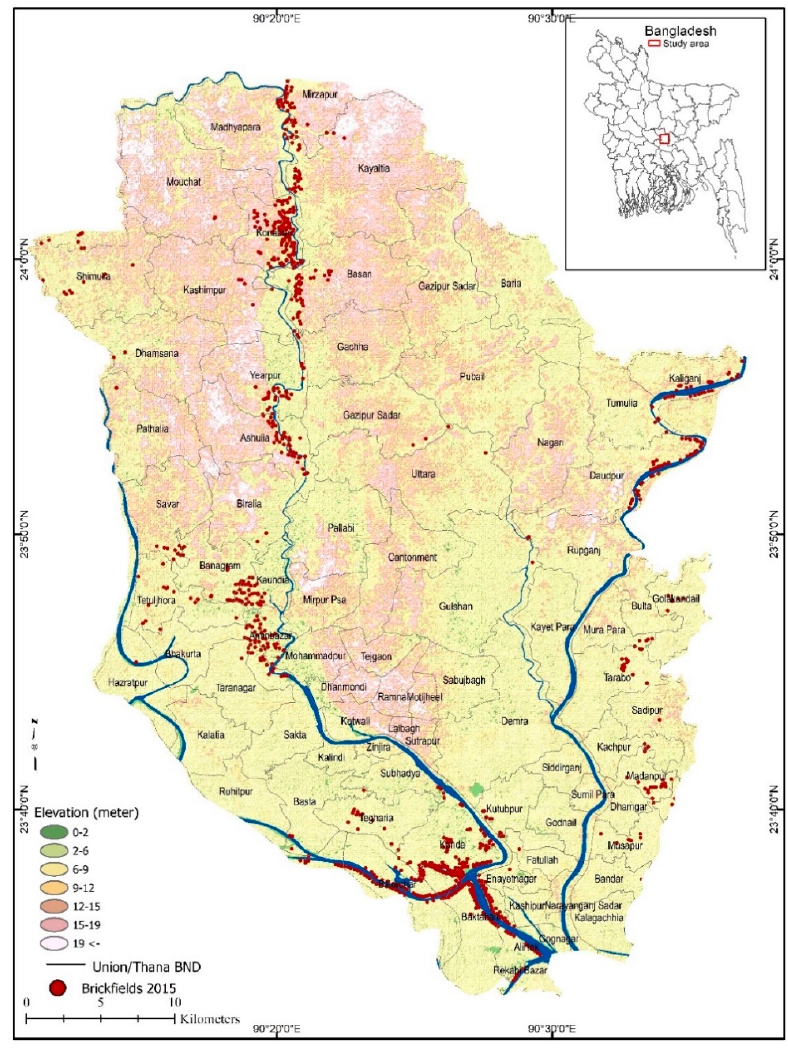
Figure 1. Elevation and brickfield locations in 2015 in greater Dhaka. Inset map in the top right corner shows the study area of greater Dhaka’s geographical position (red square box) in Bangladesh.